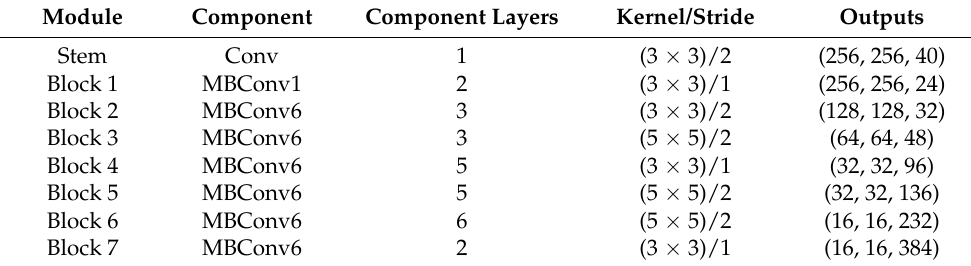
Table 1. Structure of EfficientNet-B3.